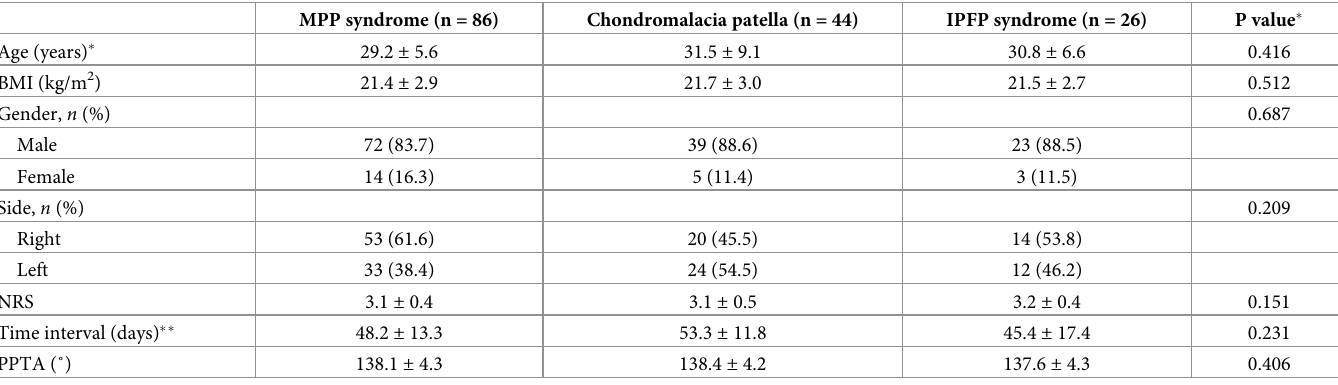
BMI = body mass index, MPP = medial patella plica, IPFP = infrapatellar fat pad, NRS = numeral rating scale, PPTA = patella-patellar tendon angle � Comparison among the three groups (MPP syndrome vs Chondromalacia patella vs IPFP syndrome) was performed with the one-way analysis of variance for continuous variables and the x2 or Fisher exact test for categorical variables. �� Time interval: interval periods from the MRI examination to arthroscopic